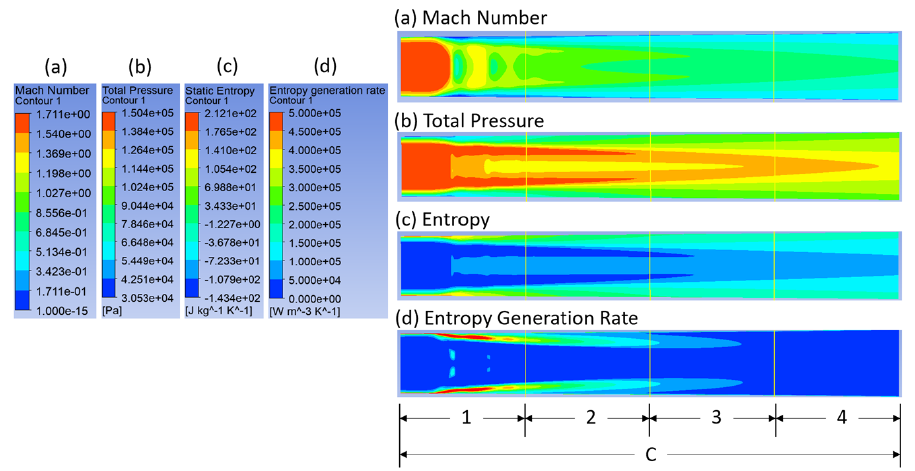
Figure 5. Contours of Mach number, static pressure, static entropy, and EGR within section C of Figure 4.